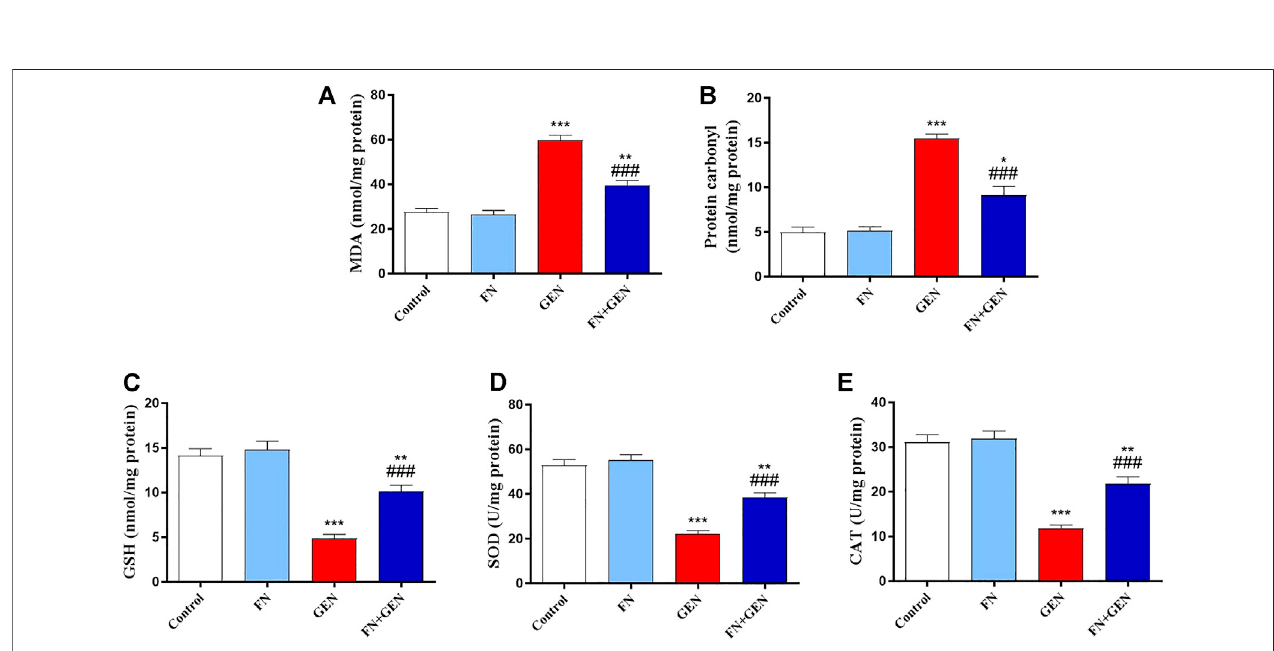
FIGURE 4 | FN ameliorates kidney oxidative stress in GEN-treated rats. Pre-treatment with FN reduced renal (A) MDA and (B) protein carbonyl levels, and increased (C) GSHlevel,andactivitiesof (D) SODand (E) CATinGEN-intoxicatedrats.Resultsaremean±SEM( n =6). p indicates p < 0.05, pp indicates p < 0.01,and ppp indicates p < 0.001versuscontrolgroup,while###indicates p < 0.001versusGEN group.FN:formononetin;GEN:gentamicin;MDA:malondialdehyde; GSH:reduced glutathione; SOD: superoxide dismutase; and CAT: catalase.